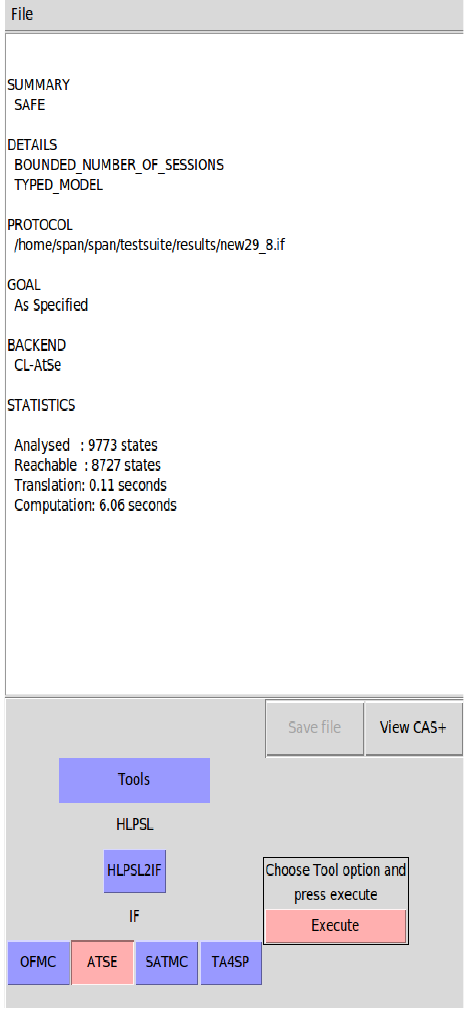
Figure 12. Formal analysis results of the advanced NF service access procedure.